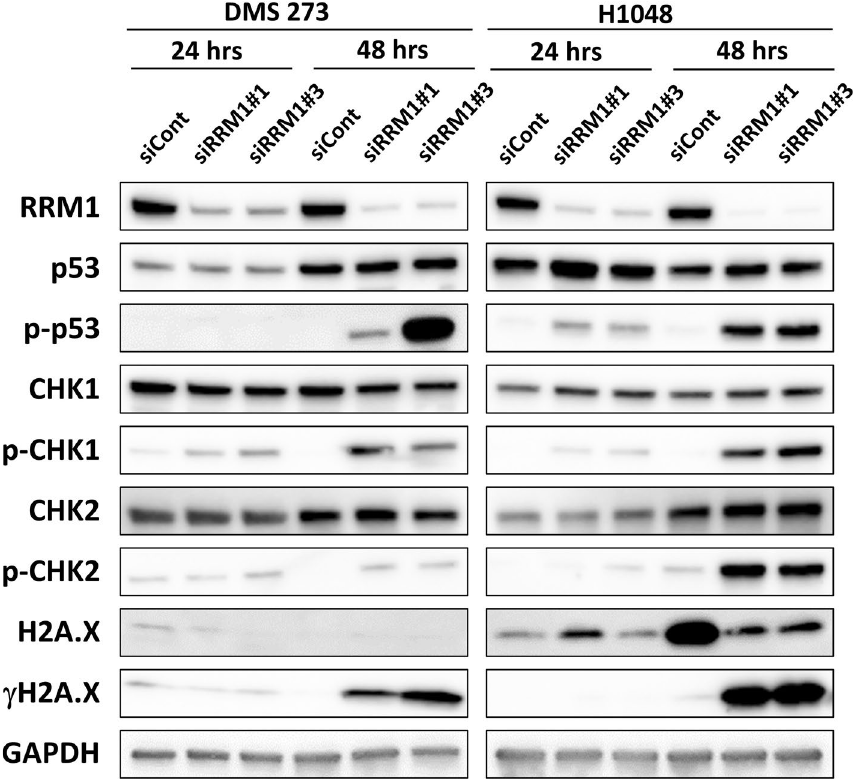
Figure 5. Representative immunoblot analysis of DNA damage-related proteins in RRM1-knockdown SCLC cells. siRNA-transfected SCLC cells were subjected to western blotting at the indicated time. Total proteins and phosphorylated (p-) proteins were detected using specific antibodies: RRM1, p53, p-p53 (S15), CHK1, p-CHK1 (S345), CHK2, p-CHK2 (T68), H2A.X, and γH2A.X (S139), with GAPDH as the loading control. The blots were cropped, and full-length blots are included in the Supplementary